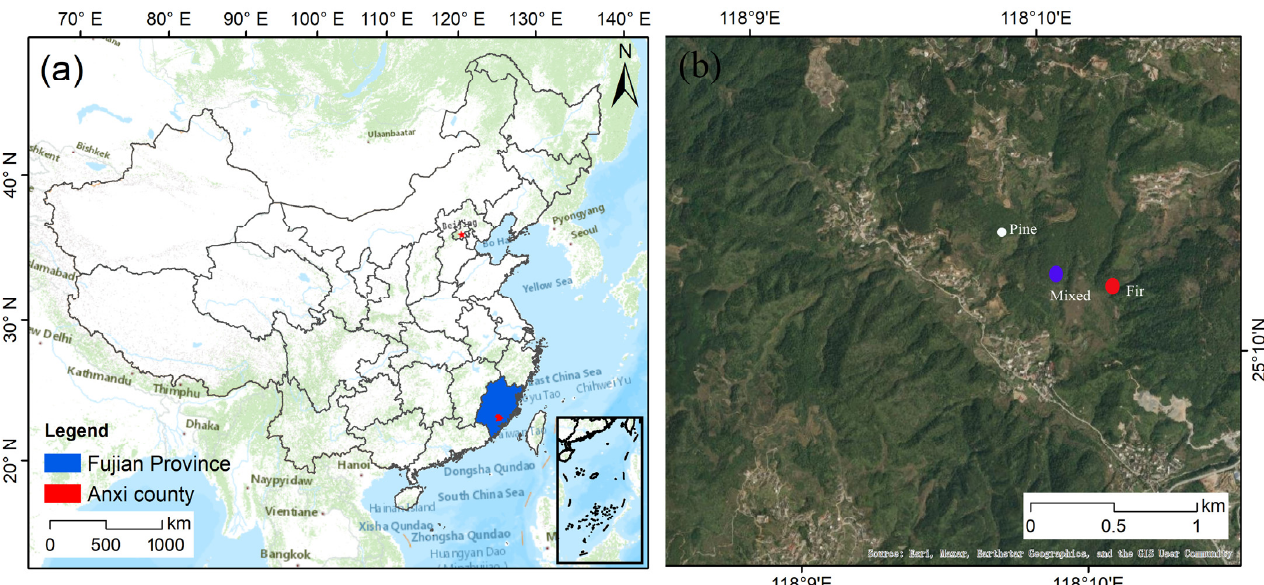
Figure 1. Study site map ( a ) and layout of sampling plots ( b ). Fir, pure C.lanceolata forest; Pine,